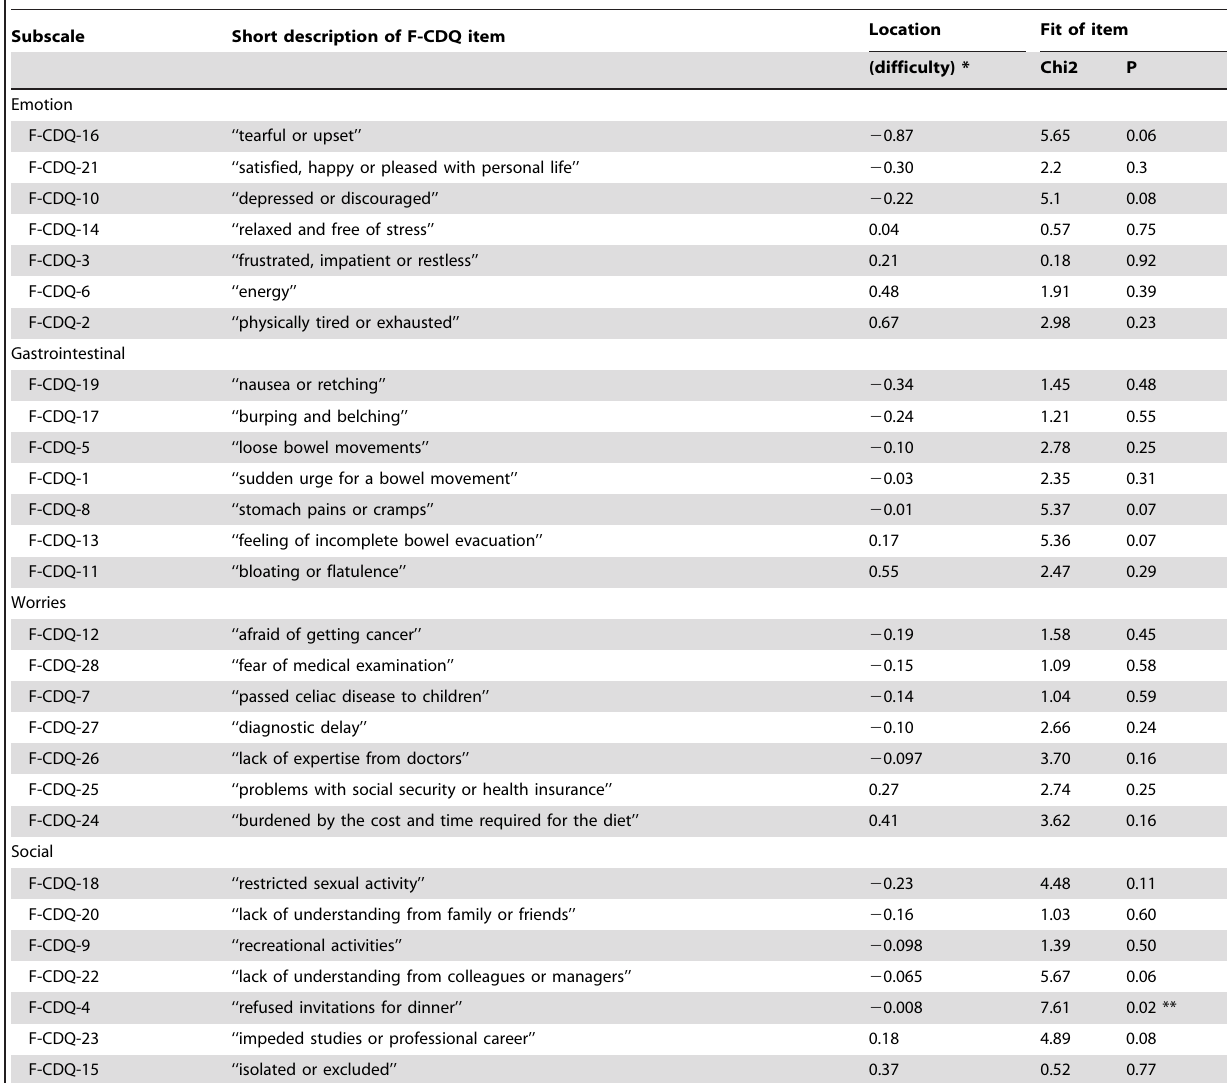
Table 3. Rasch analysis of the four subscales of the French version of the ‘‘Celiac Disease Questionnaire’’ (F-CDQ).